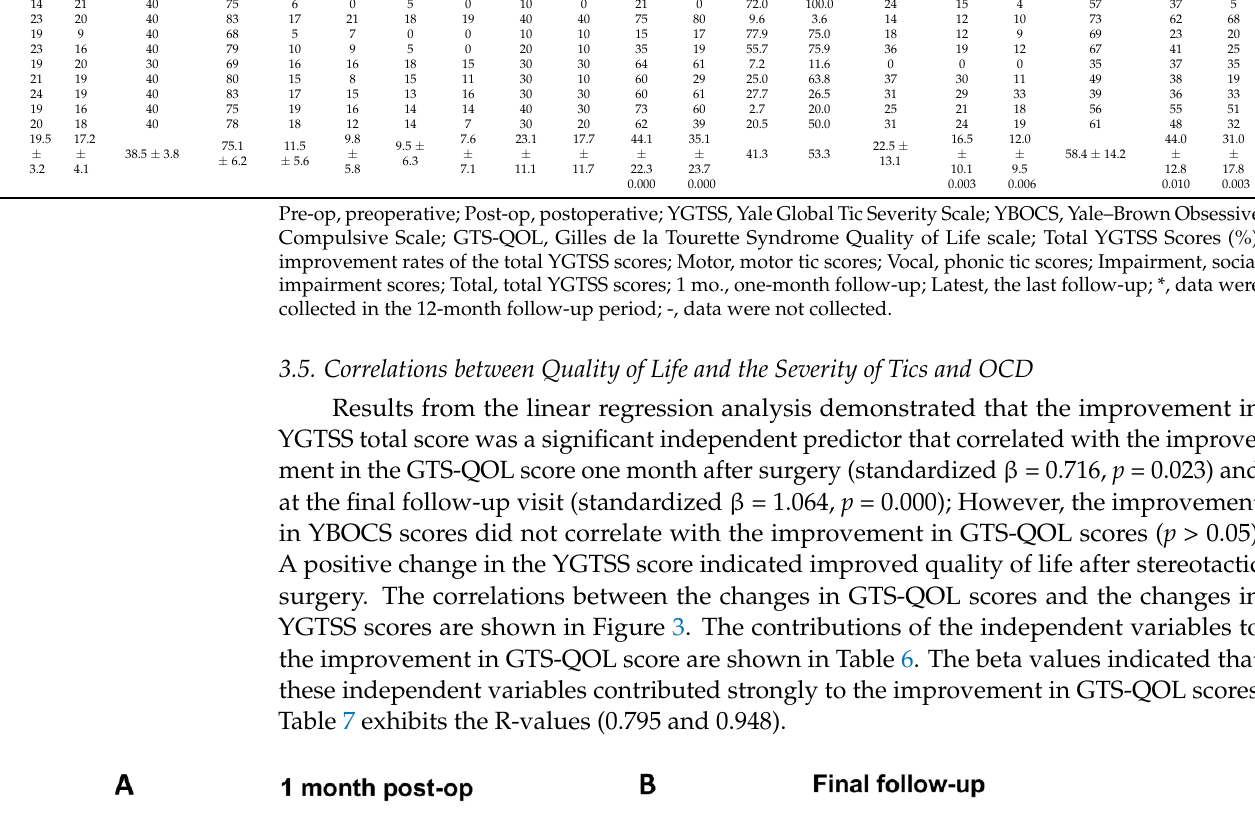
Table 7. Model summary of improvement in GTS-QOL score based on linear regression analyses.